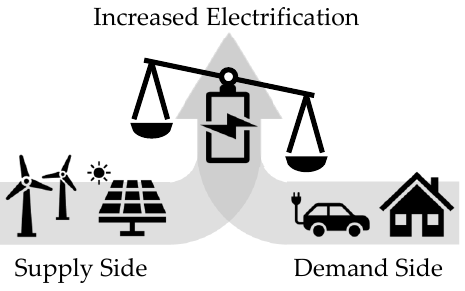
Figure 1. The pathway towards a low-carbon society utilizing cleaner production and consumption of electric energy.